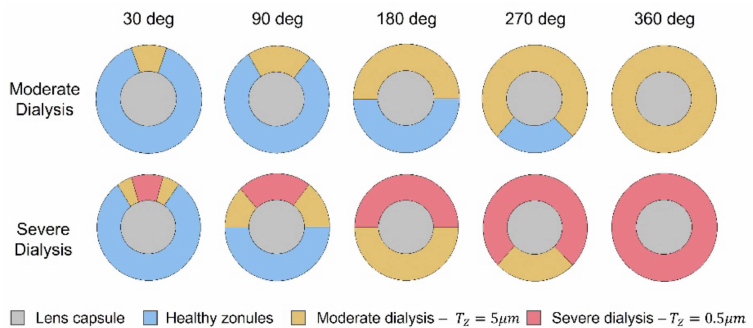
Figure 3. Frontal view schematic of the models with superior zonular